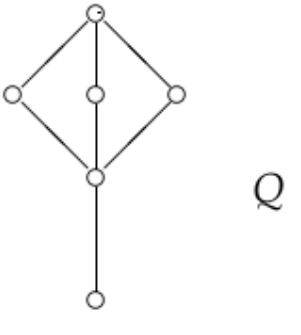
Figure 1. Then, { d i , i ∈ I } has a bottom element.